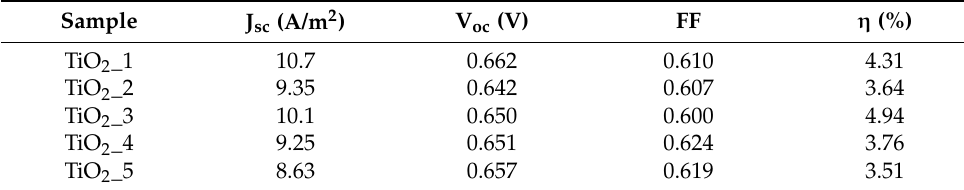
Table 1. TiO 2 DSSC electrical characteristics data.